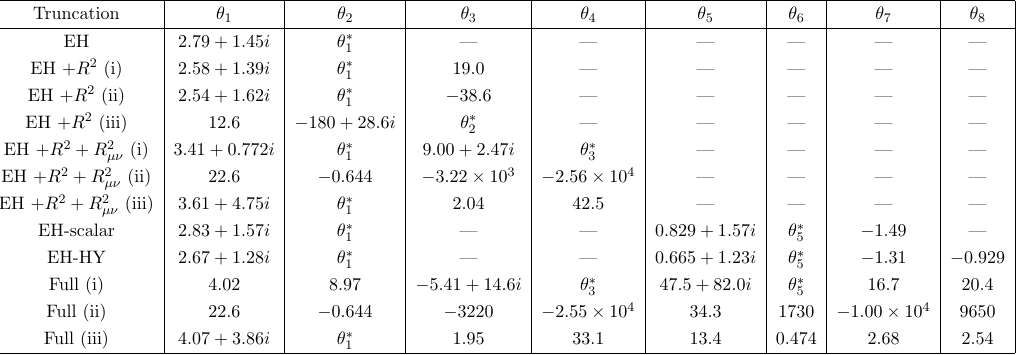
Table 4 . The values of critical exponents for (cid:11) = 0 and (cid:12) =